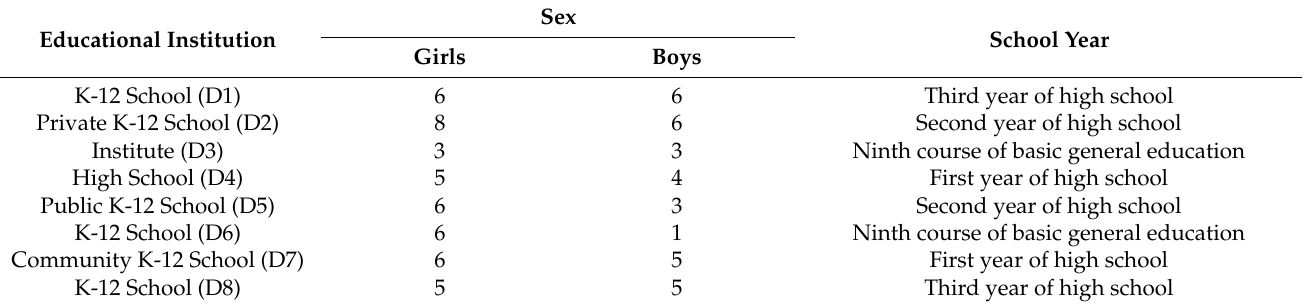
Table 2. Participant